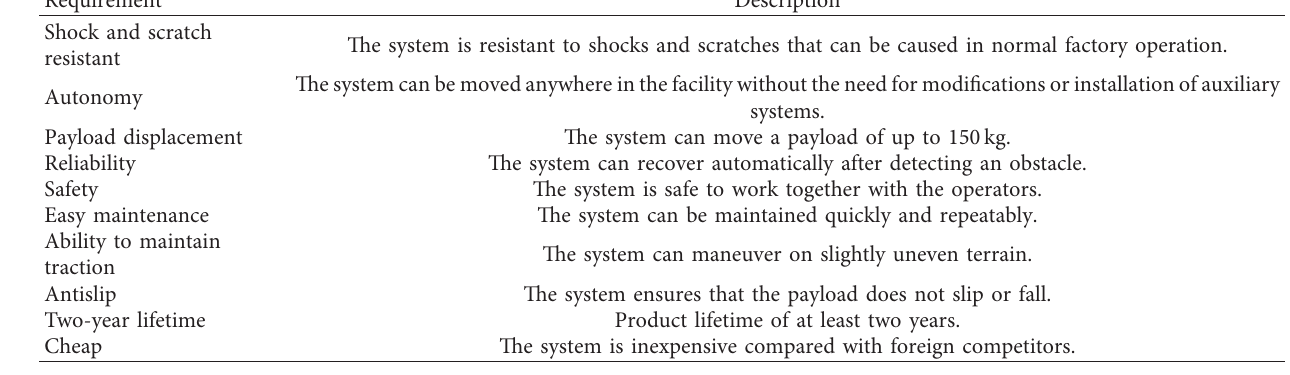
Table 1: Customer requirements.